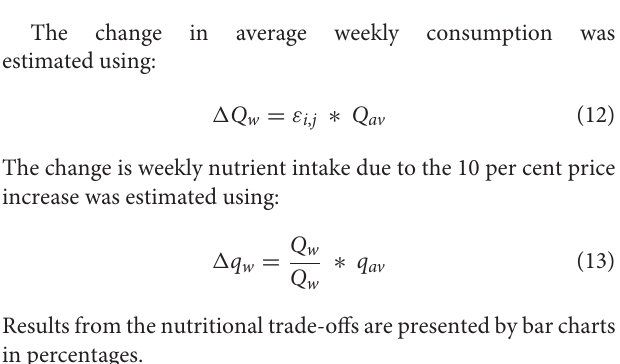
Protein Carbohydrate (g/100g) (g/100g)